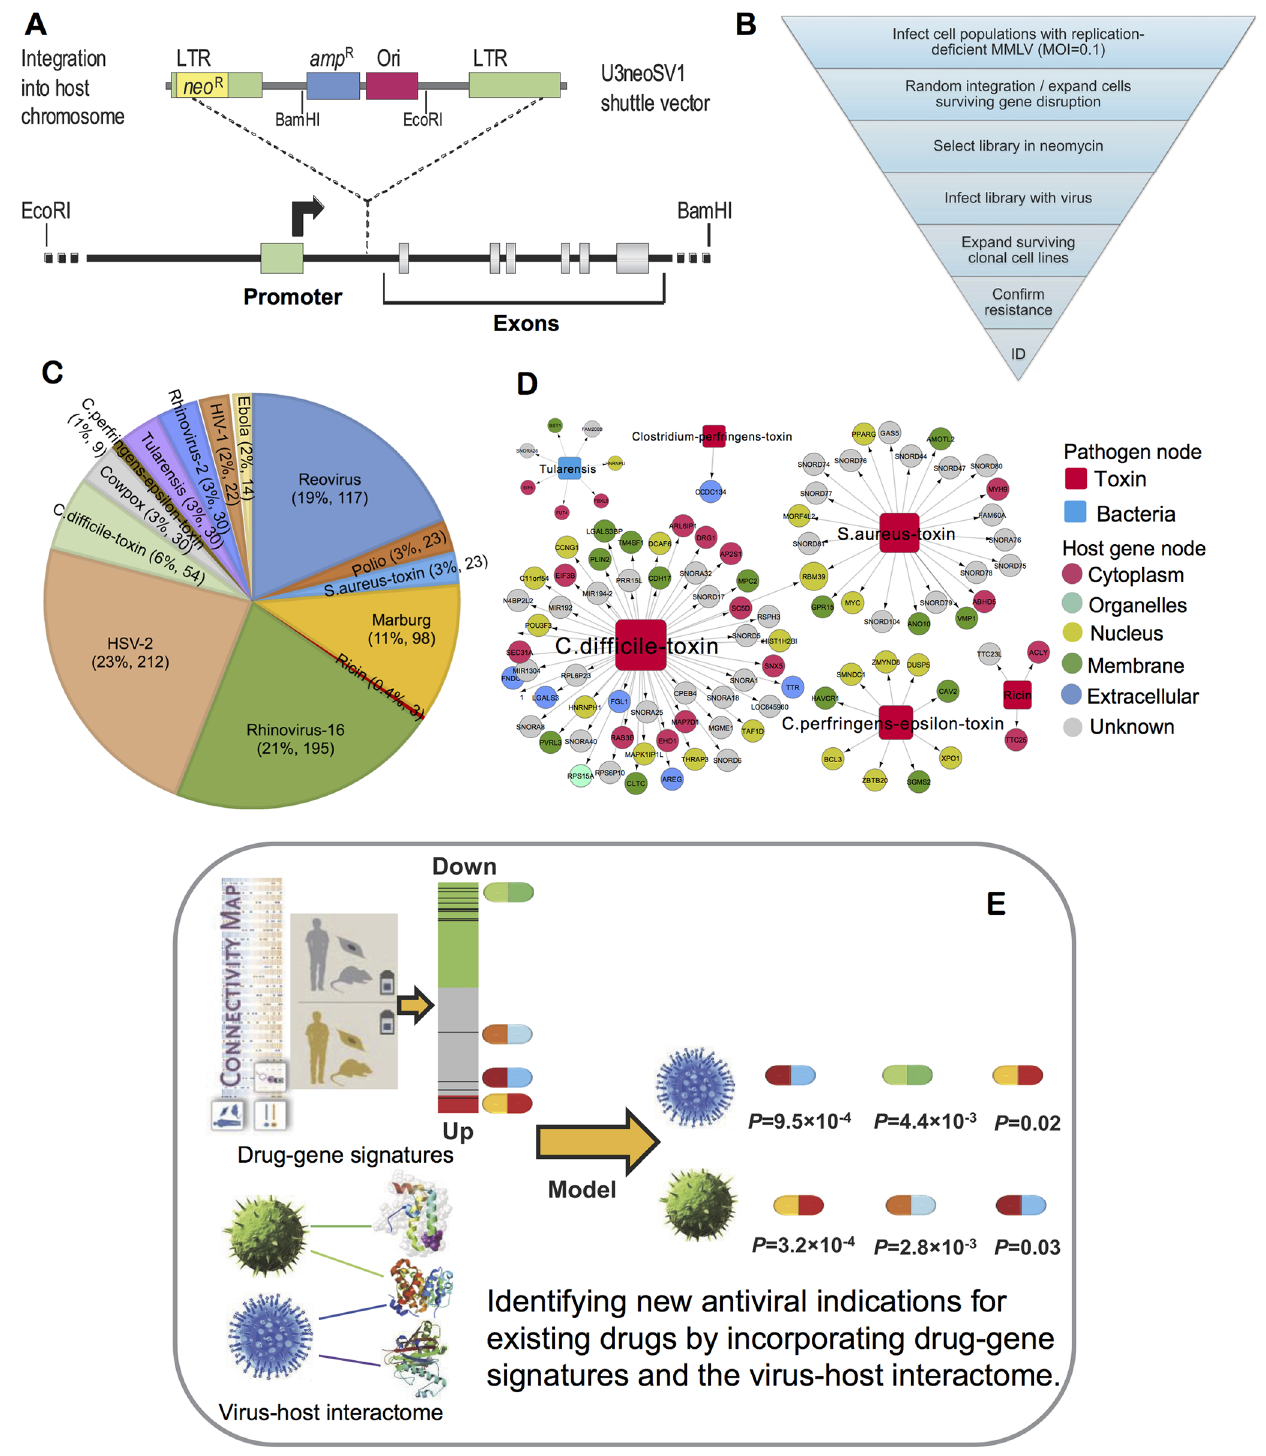
Fig 1. Diagram of the integrative antiviral drug discovery pipeline. ( A ) The gene-trap insertional mutagenesis approach employs an MMLV- based shuttle vector that randomly integrates into host cell chromosomes and contains a promoterless neomycin-resistance gene. Shuttle vector integration between a host-cell promoter and an early exon disrupts (traps) the gene, allowing neomycin selection and derivation of a gene-trap library. ( B ) Host genes mediating the toxic effects of lytic viral replication or exposure to toxins were identified by: (i) selecting gene- trap libraries in neomycin; (ii) exposing gene-trap library cells to a lytic virus or a toxin; (iii) isolating surviving clones; (iv) resistance confirmation